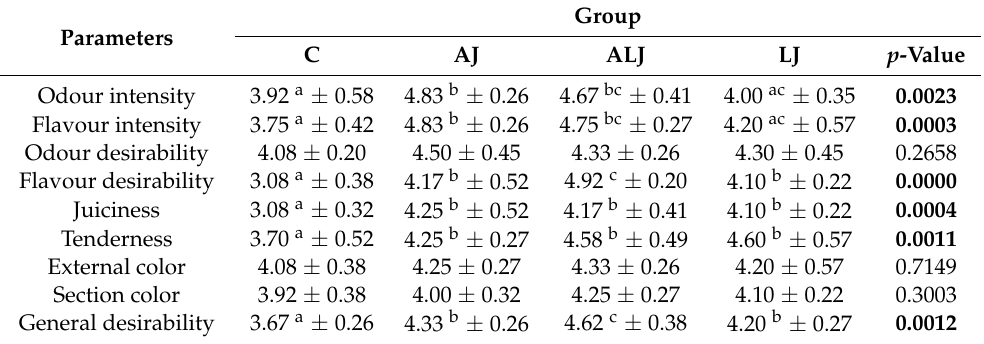
Table 2. Impacts of fruit juice marinating on the sensory assessment of marinated roasted prod- ucts (points).